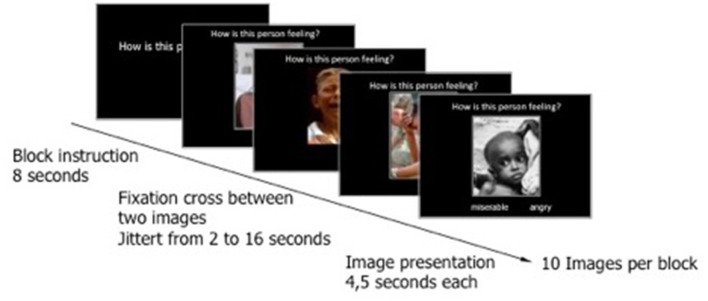
Presentation of an experimental block. Cognitive empathy as an example. Each block has started with a block question and continued with 10 stimuli including a picture depicting a person in a negative emotional state, the typical block question, and the dichotomous answers.